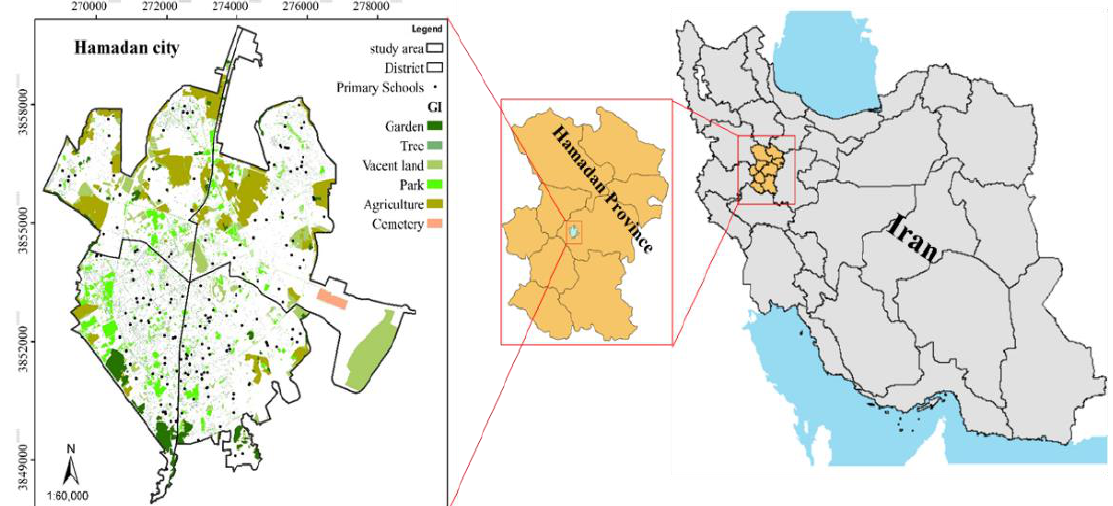
Fig. 1. Location of study area (Hamadan